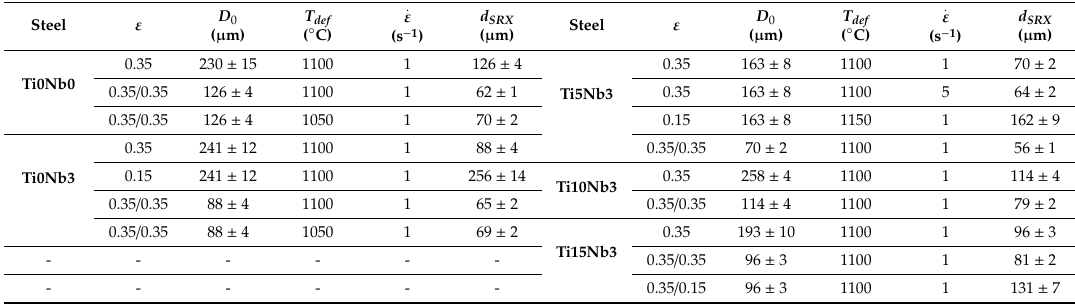
Table 3. Experimental d SRX determined at di ff erent deformation conditions.